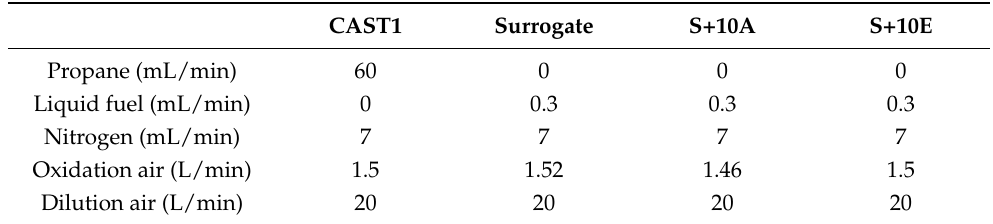
Table 1. Flow rates of the operating conditions studied. CAST1 Surrogate S+10A S+10E Propane (mL/min) 60 0 0 0 Liquid fuel (mL/min) 0 0.3 0.3 0.3 Nitrogen (mL/min) 7 7 7 7 Oxidation air (L/min) 1.5 1.52 1.46 1.5 Dilution air (L/min) 20 20 20